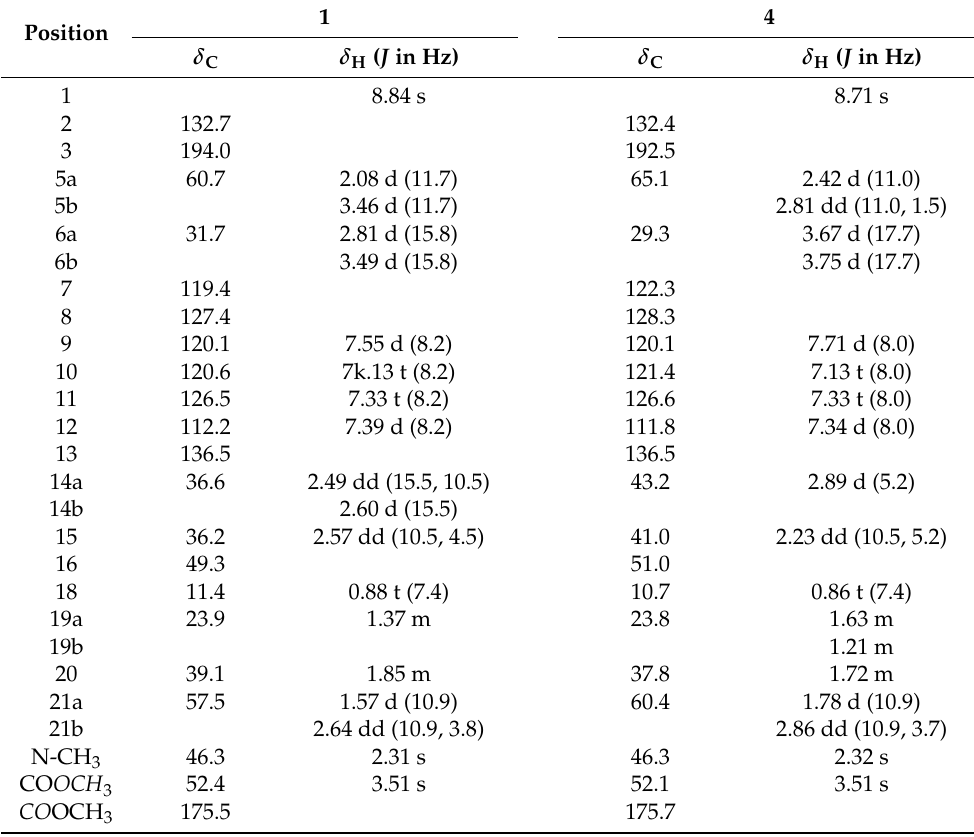
Table 1. 1 H and 13 C NMR data of compounds 1 and 4 (in CDCl 3